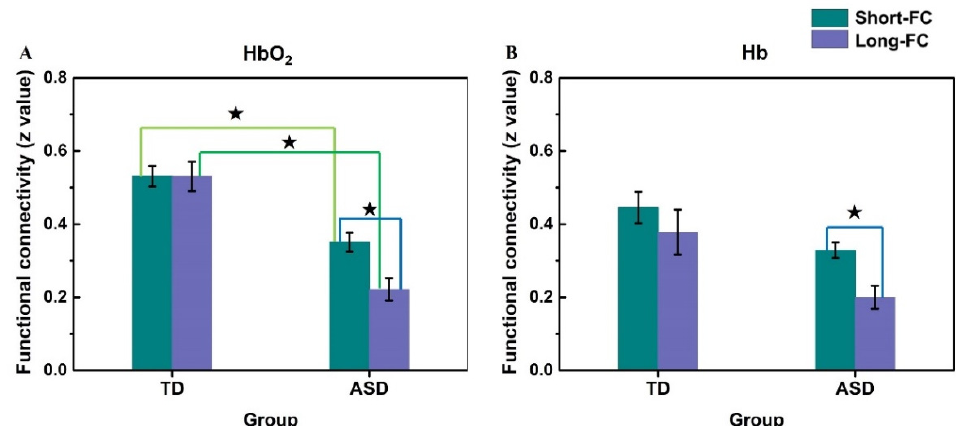
Figure 4. The average of short-range RSFC (Short-FC) and homotopic long-range RSFC (Long-FC) based on HbO 2 ( A ) and Hb ( B ) in the bilateral temporal lobes for ASD and TD groups. The error bar is the standard error of the mean. For HbO 2 -RSFC, in the TD group, the z-value was 0.53 ± 0.03 for Short-FC, and 0.53 ± 0.04 for Long-FC, while in the ASD group, the z-value was 0.35 ± 0.03 for Short-FC, and 0.22 ± 0.03 for Long-FC. For Hb-RSFC, in the TD group, the z-value was 0.45 ± 0.04 for Short-FC, and 0.38 ± 0.06 for Long-FC, while in the ASD group, the z-value was 0.33 ± 0.02 for Short-FC, and 0.20 ± 0.03 for Long-FC. The short-RSFC was significantly stronger than the long-RSFC in the ASD group in both HbO 2 and Hb, whereas, in the TD group, there was no significant difference between the short- and long-RSFC in either HbO 2 or Hb. For HbO 2 , both the short- and long-RSFC were weaker in the ASD than TD group. The symbol (cid:70) indicates the difference is significant.